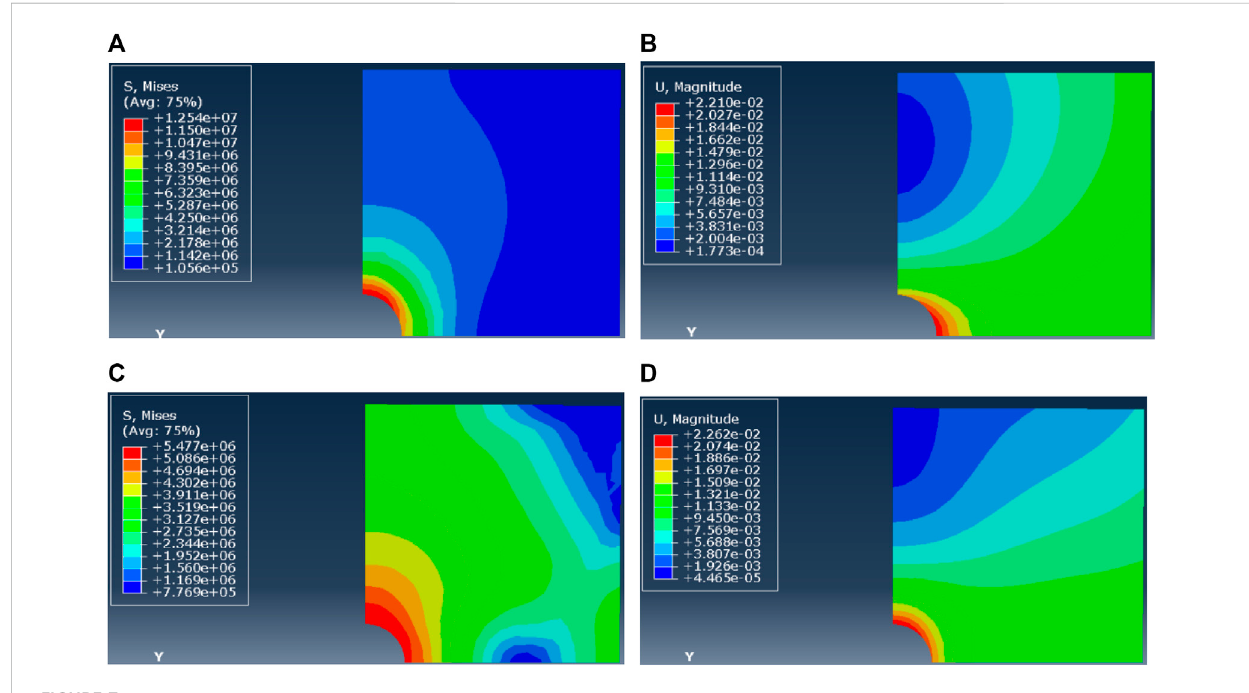
FIGURE 7 (A – D) Mises stress and displacement of borehole shrinkage after reaming ( Δ P = 1 MPa, n = 1); Mises stress and displacement of borehole shrinkage after reaming ( Δ P = 1 MPa, n = 5)